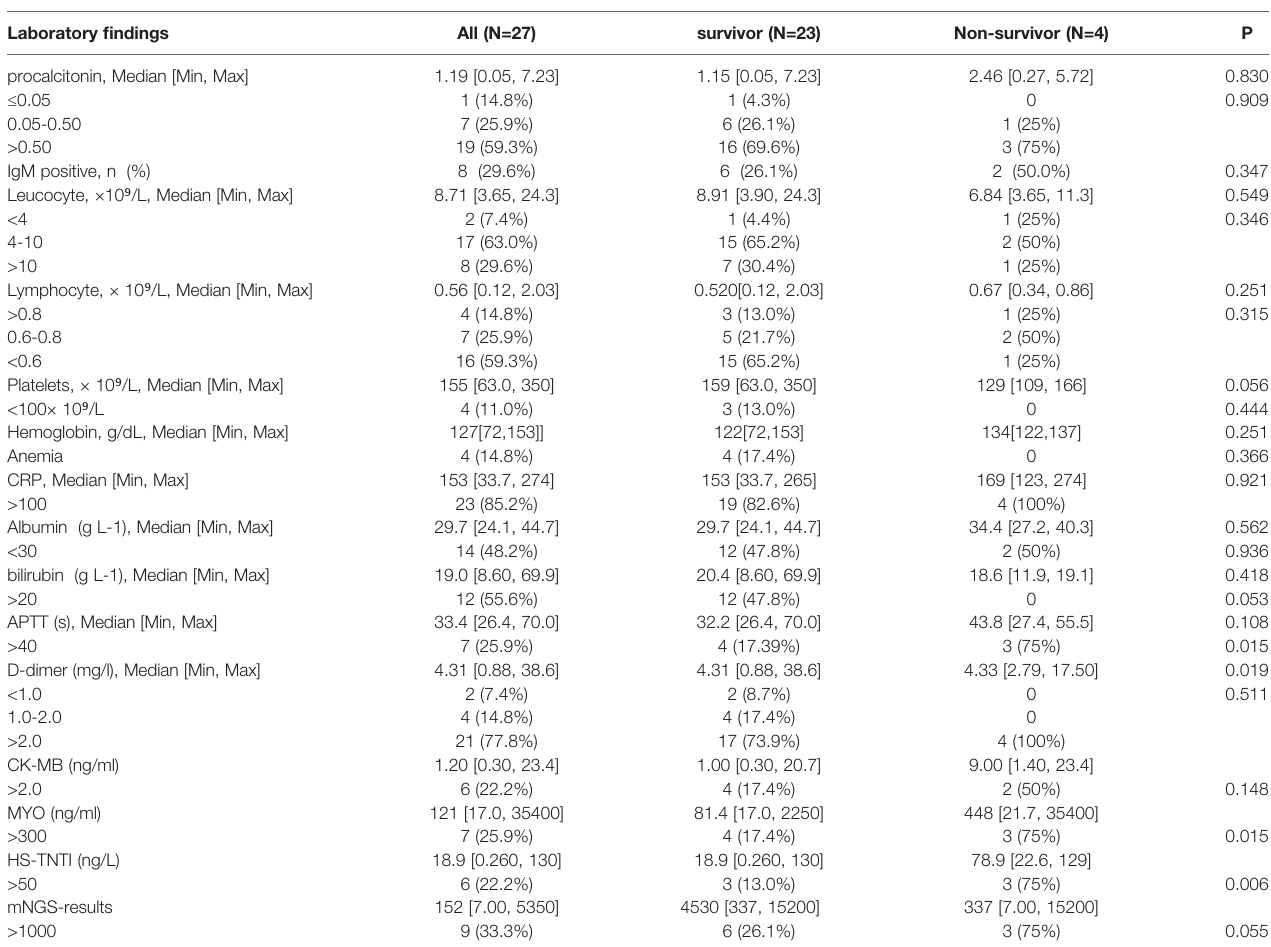
TABLE 2 | Laboratory